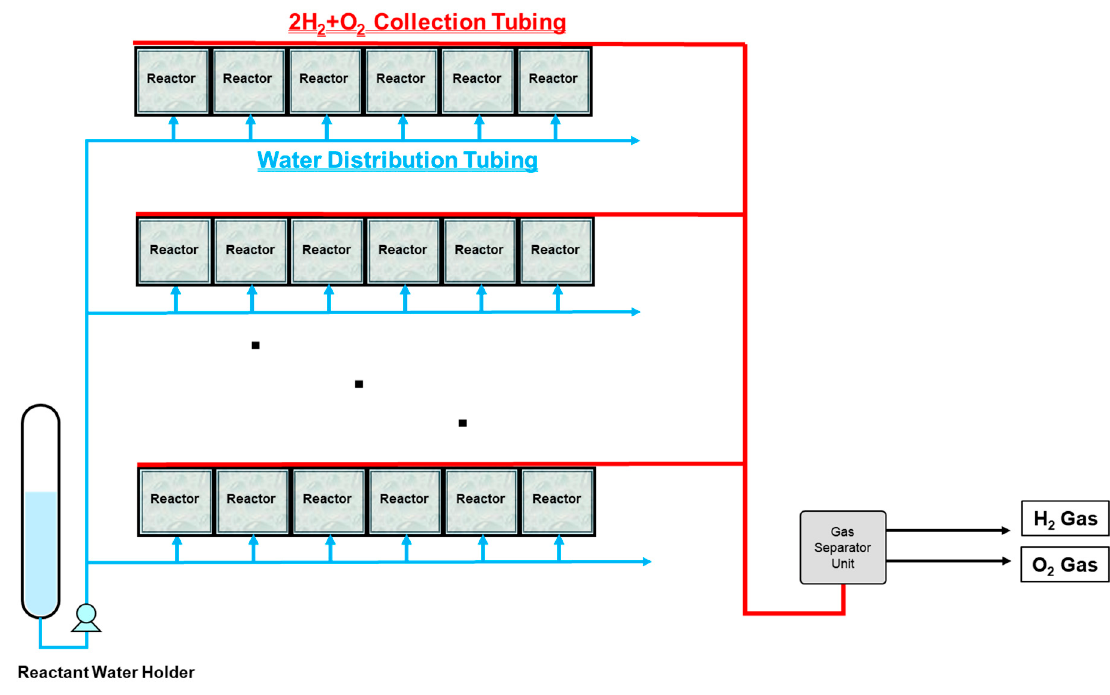
Figure 7. A schematic drawing of our overall water photo-splitting pilot plant. A number of unit water splitting photocatalytic reactors, charged with 0.6%-STH RhCrO x /Al:SrTiO 3 photocatalyst sheets, are arrayed filling the plant area. The reactors are daisy-chained with tubes for transporting the product 2H 2 + O 2 gas, as well as with pure water supplying tubes. The product transportation tubes are gathered and connected to a gas separator unit to put H 2 and O 2 into two output tubes. The gas separator unit consists of inorganic filter membranes and motor-driven gas pumps for filtration as well as for desiccation.